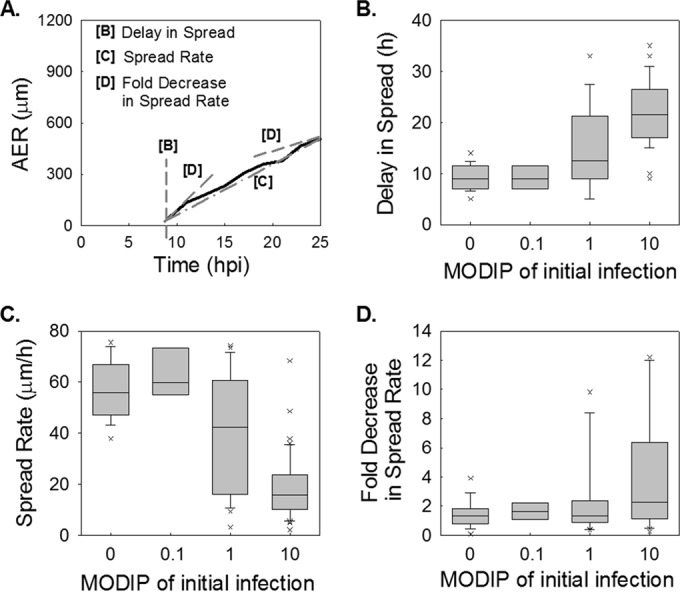
Interfering effects of initial DIPs on initial delay and the subsequent rate of infection spread. (A) Schematic illustration of how parameters are extracted from distance-versus-time data (solid line). Delay in spread, spread rate, and fold decrease in spread rate were extracted from plaque expansion profiles, shown as the area equivalent radius (AER) versus time. (B to D) The distributions of extracted features at each MODIP (abscissa) are shown as box plots. The gray boxes cover 25%-to-75% confidence intervals, while whiskers span 5% to 95%. The horizontal lines in the boxes represent medians, and each outlier is indicated by a lowercase letter x. (B) Delay is the first time point at which the fluorescence intensity exceeds the lower detection limit in the initially infected cell. (C) The spread rate is calculated by linear approximation of expansion profiles. (D) The fold decrease in the spread rate is the ratio of the instantaneous spread rate (slope of line [D] in panel A) at the last three time points to that at the earliest three time points.